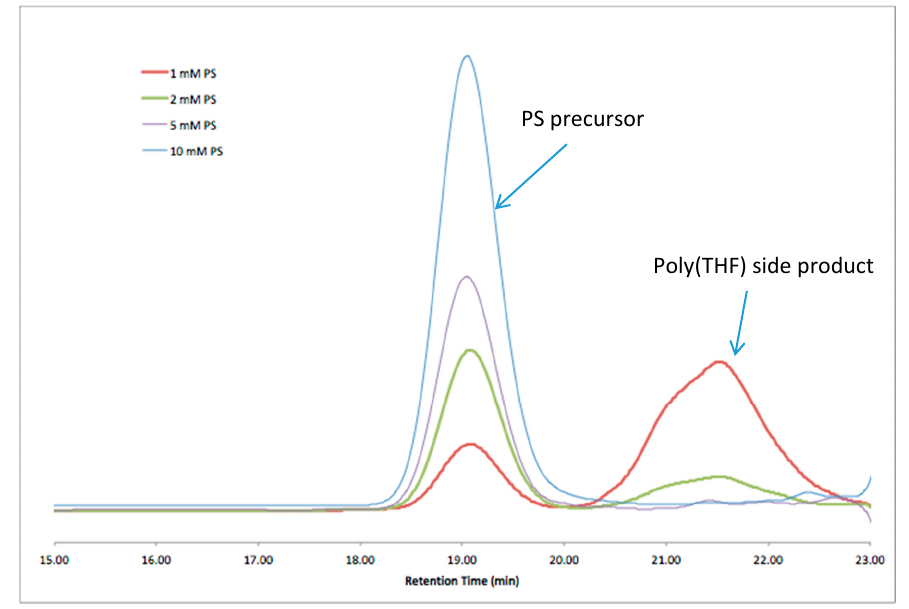
Figure 6. GPC traces of unfunctionalized PS (purchased from Agilent, eluting between 18.5 and 20.0 min) and the results of several mock cyclization reactions at varying concentrations of reactants ranging from 1 mM PS to 10 mM PS. In all cases, [PS]:[CuBr]:[Cu]:[PMDETA] = 1:5:5:10.